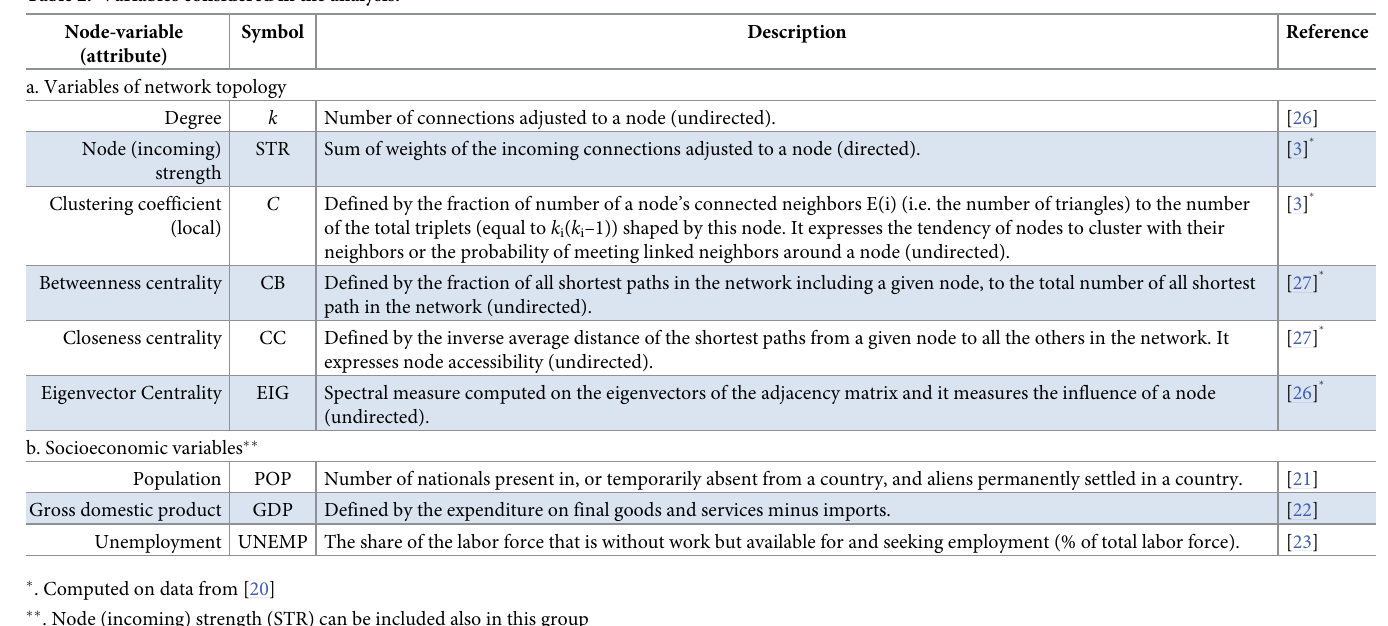
Table 2. Variables considered in the analysis.